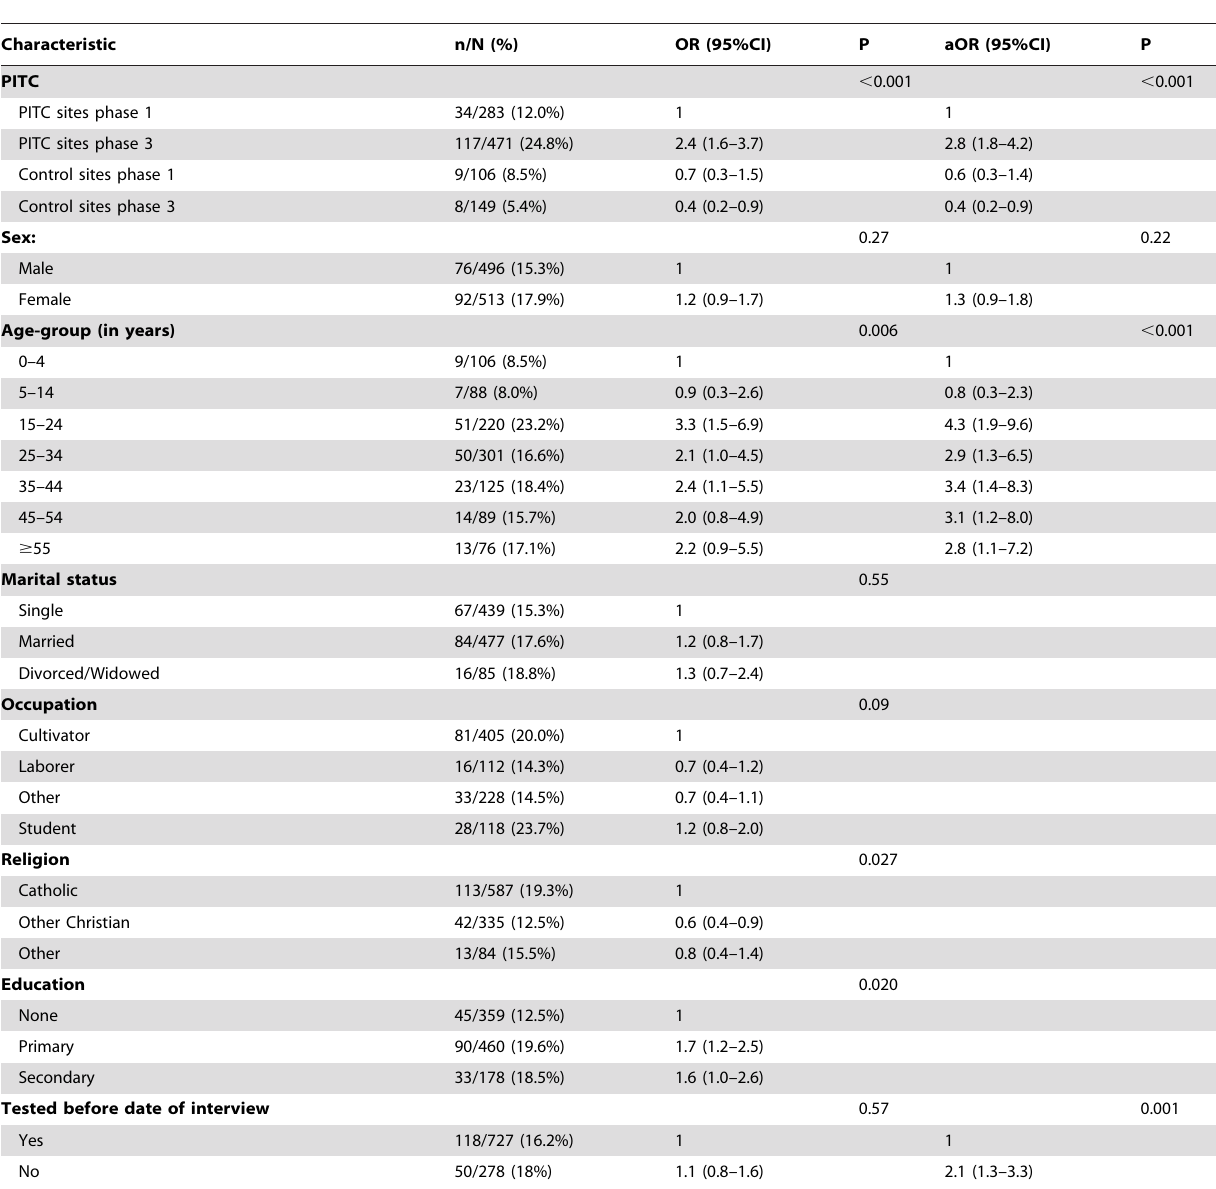
Table 6. Association between having been tested for HIV on day of interview and demographic characteristics and testing history among 1009 attendees of the OPD at 8 clinics, Rwanda, 2009–10.